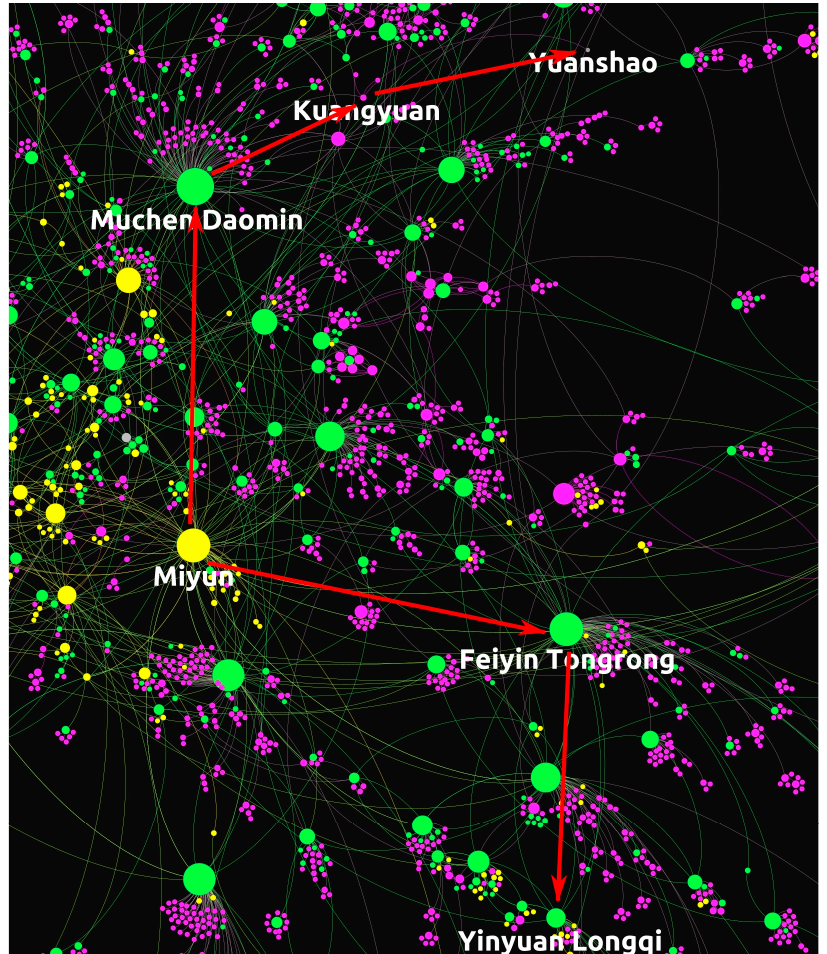
Figure 6. Transmission of Miyun’s school to Japan (Feiyin Tongrong ⟶ Yinyuan Longqi (A001873)) and Vietnam (Muchen Daomin ⟶ Kuangyuan Benguo 曠圓本果 (A021838) ⟶ Yuanshao 元韶 (A044921)). Yellow nodes: actors born and died in the Ming. Green nodes: born in the Ming and died in the Qing. Magenta nodes: born and died in the Qing.